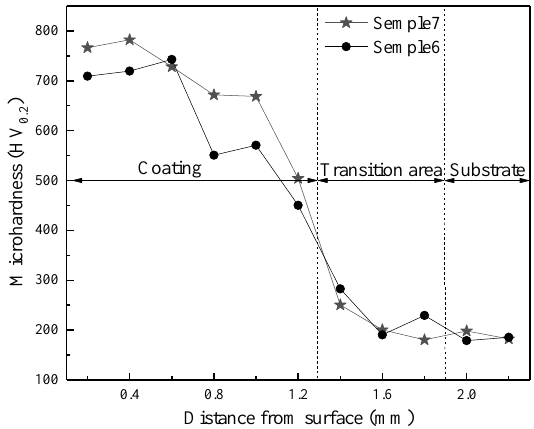
Figure 12. Microhardness values of samples 6 and 7.